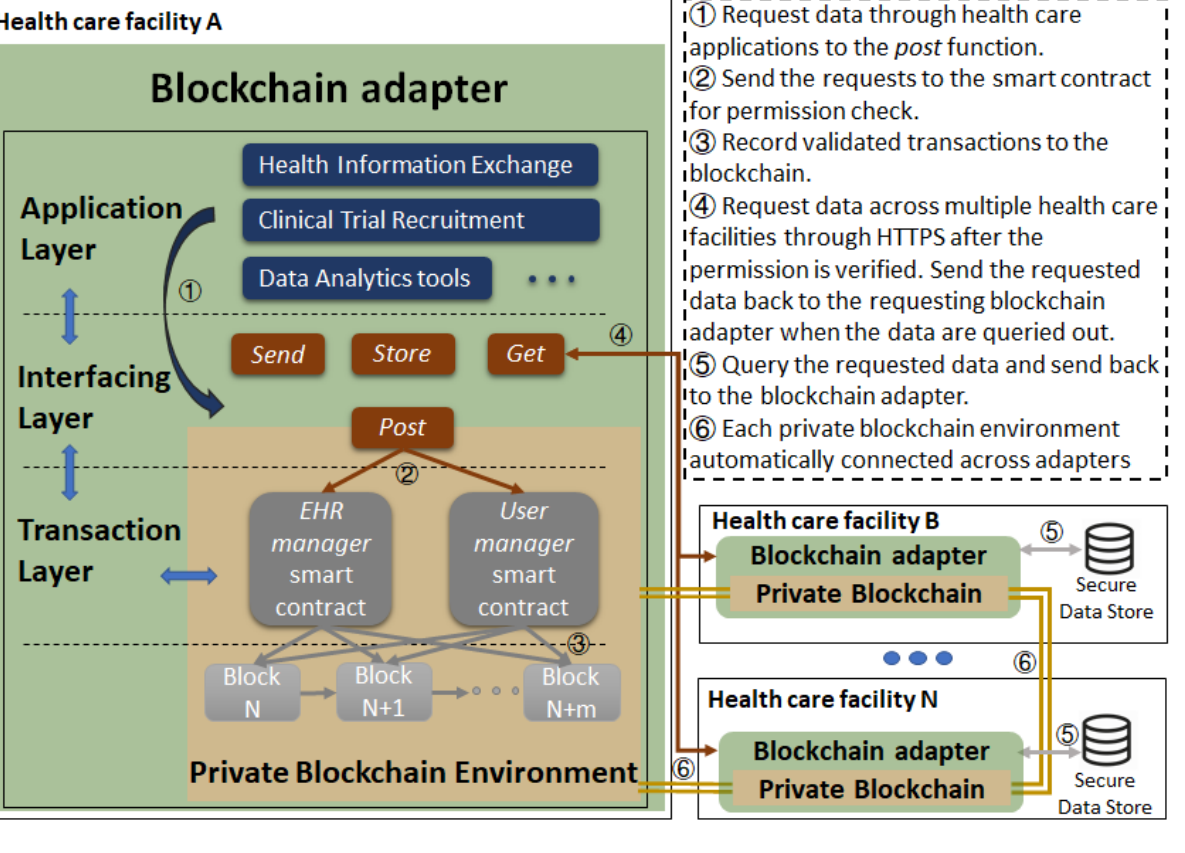
Figure 1. Overall layered blockchain architecture. The transaction layer consists of 2 smart contracts to manage data access tasks. The interfacing layer interacts with the blockchain environment, graphical user interfaces, and other blockchain adapters. The application layer provides a flexible platform for health care application development. The figure shows the general process of data requests using the architecture. EHR: electronic health